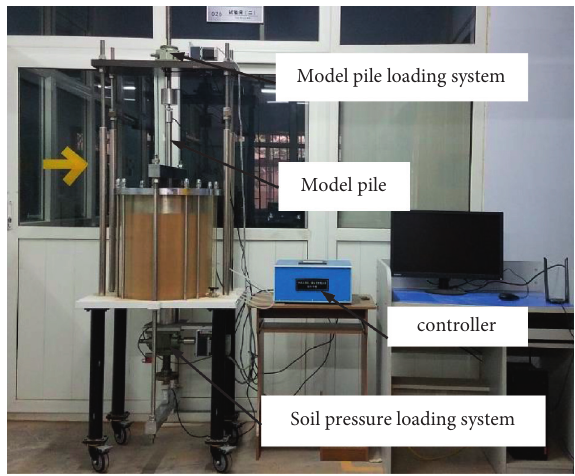
Figure 2: Physical drawing for the model